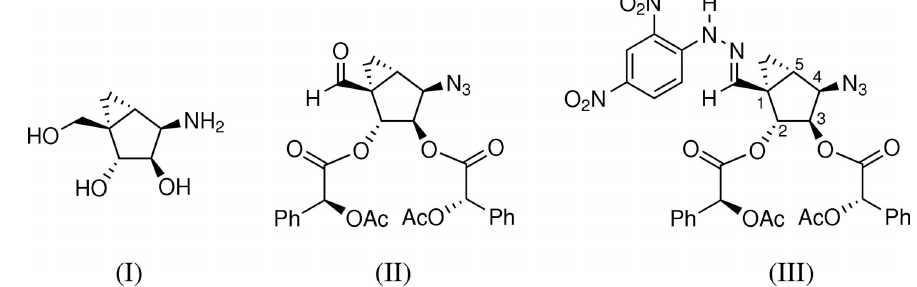
Scheme showing compounds (I), (II) and